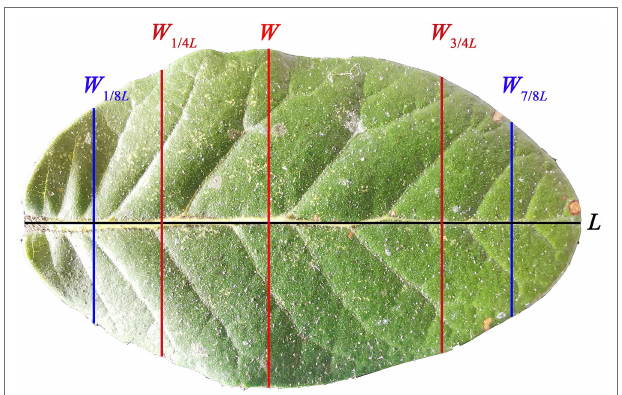
FIGURE 1 | Adaxial surface (i.e., the upper image) of a representative leaf of Quercus pannosa . L represents the leaf length; W represents the maximum leaf width; W 1/4 L represents the leaf width associated with 1/4 L from leaf base; W 3/4 L represents the leaf width associated with 3/4 L from leaf base; W 1/8 L represents the leaf width associated with 1/8 L from leaf base; W 7/8 L represents the leaf width associated with 7/8 L from leaf